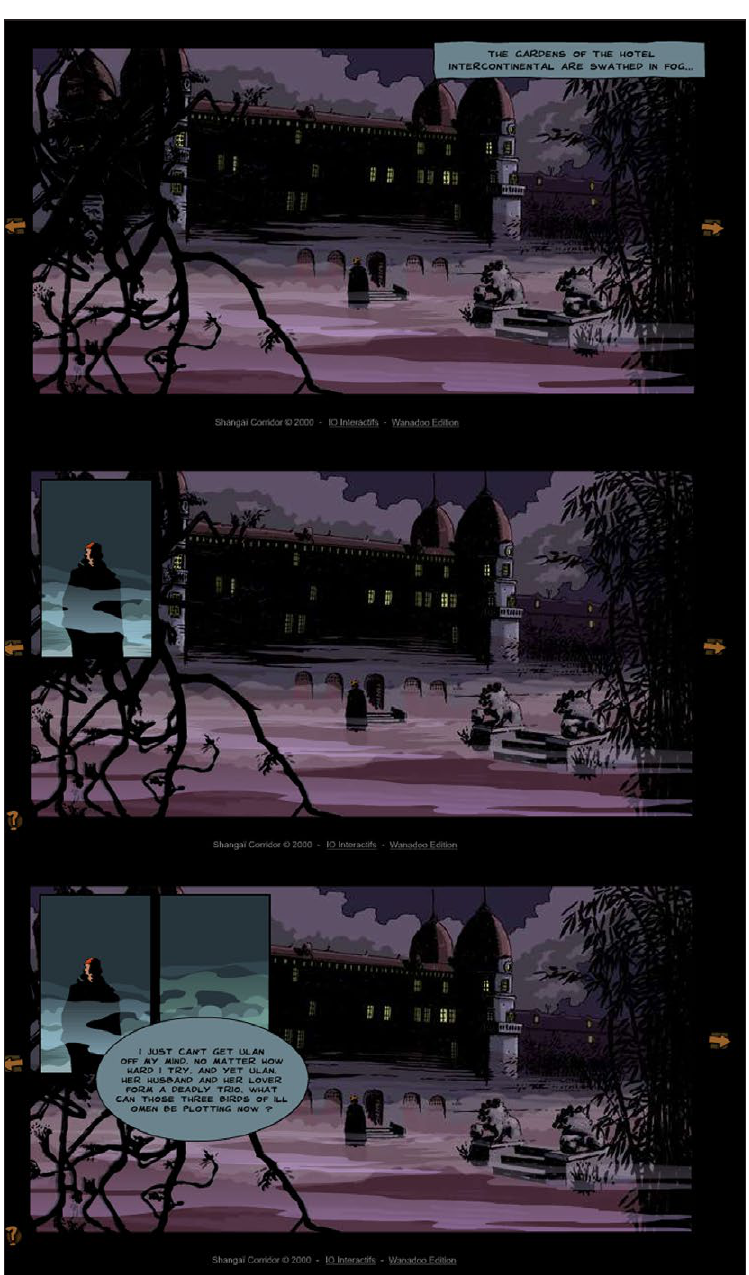
Figure 3: Three sequential screenshots showing the diaporama format of John Lecrocheur . Guibert S. and Malland J., John Lecrocheur (I/O Interactifs and Wanadoo Éditions, 1998–1999). Available at: https://www.criticalsecret.com/ lecrocheur/en/ep1.html [Last accessed 11 February 2016]. © Julien Malland et Simon Guibert & I/O Interactifs &